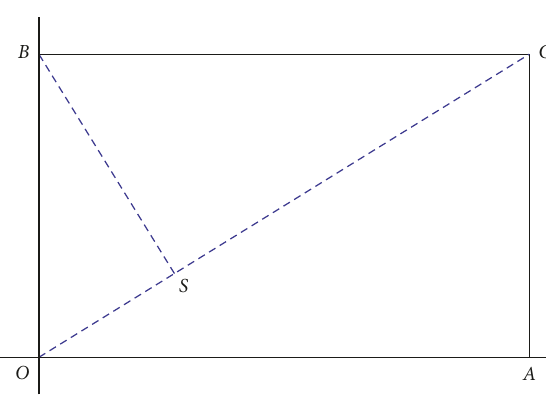
Figure 2: Geometric approach of the shrinkage